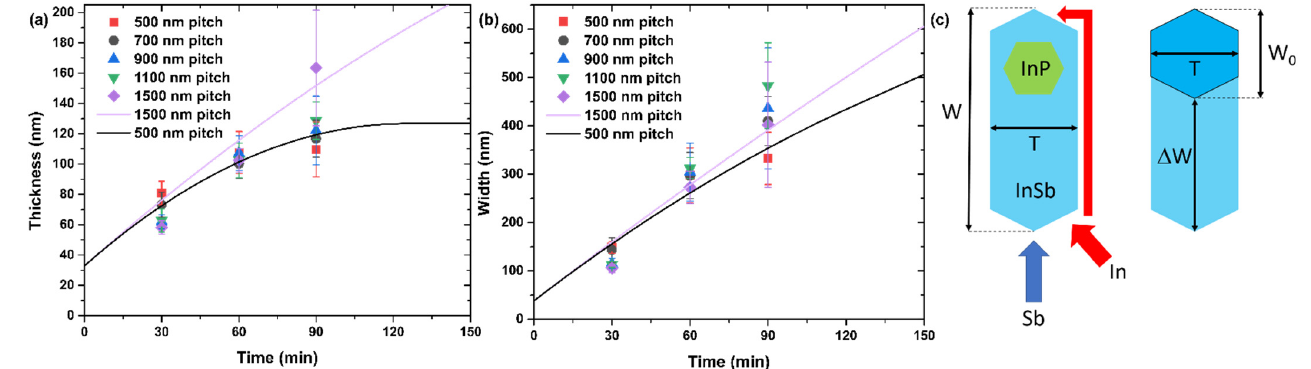
Figure 3. ( a ) Width 𝑊 and ( b ) thickness 𝑇 of InSb NFs versus growth time for different pitches 𝑎 shown in the legend. ( c ) Illustration of the NF geometrical parameters from top view used in the model. Lines in ( a , b ) show the fits for pitches 𝑎 = 1500 and 500 nm obtained within the model. Time evolution of the length of InSb NFs can be quantified using the following